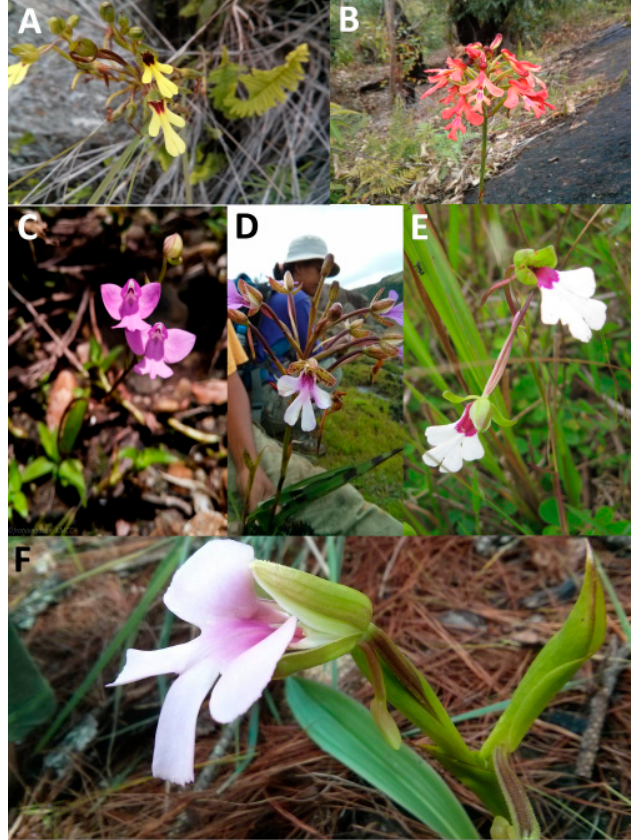
Figure 3. Some of the Cynorkis species from which fungi were isolated. ( A ) Cynorkis flexuosa , ( B ) C. gibbosa , ( C ) C. purpurea , ( D ) C. × ranaivosonii , ( E ) C. speciosa , ( F ) C. uniflora .